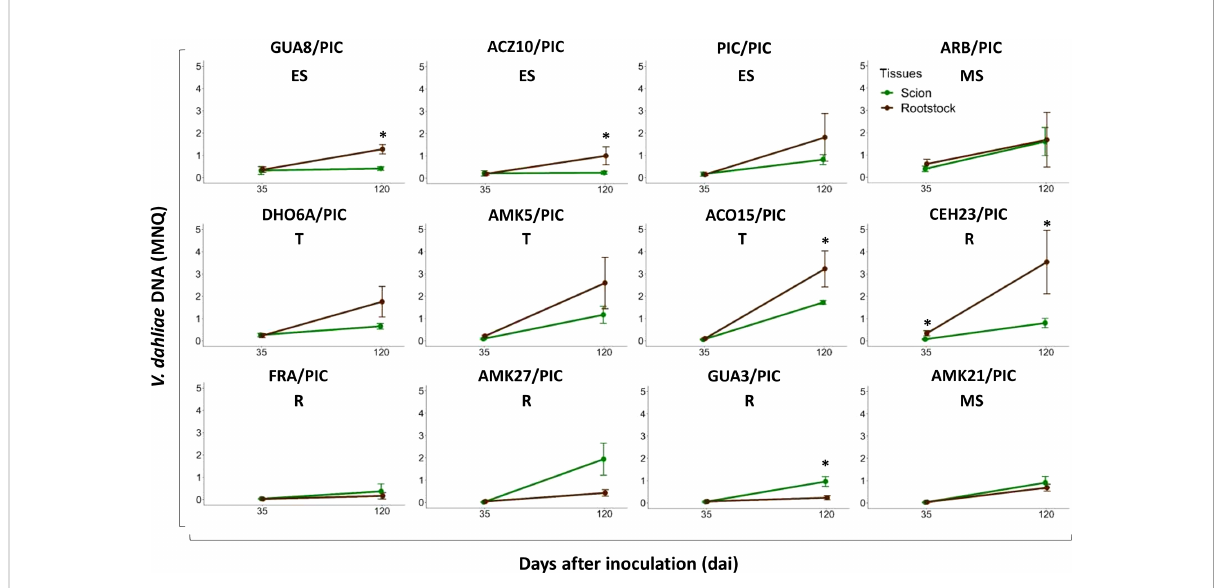
FIGURE 7 Evolution of Verticillium dahliae DNA content in ‘ Picual ’ scions (green line) and rootstock trunks (brown line) at 35 and 120 days after inoculation (dai) with the defoliating isolate VD117. Points represent the mean of 4 values (one value per block) for each genotype. Error bars represent the standard error of the mean. Asterisks indicate signi fi cant differences between different tissues at the same